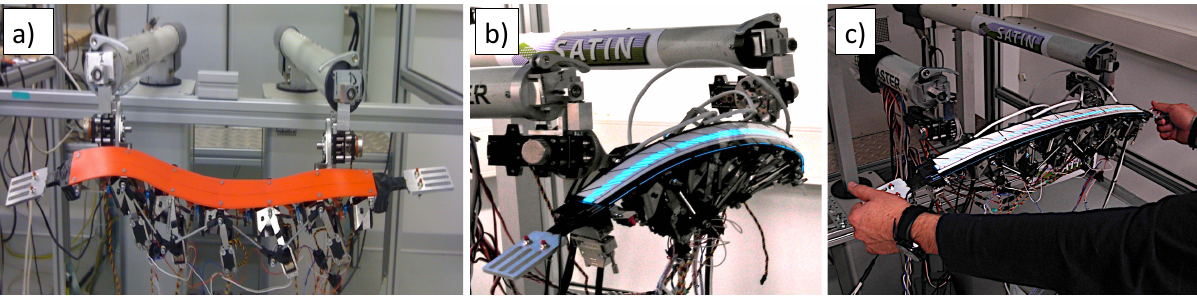
Figure 6. Aluminum sensorized extremities mounted on the haptic